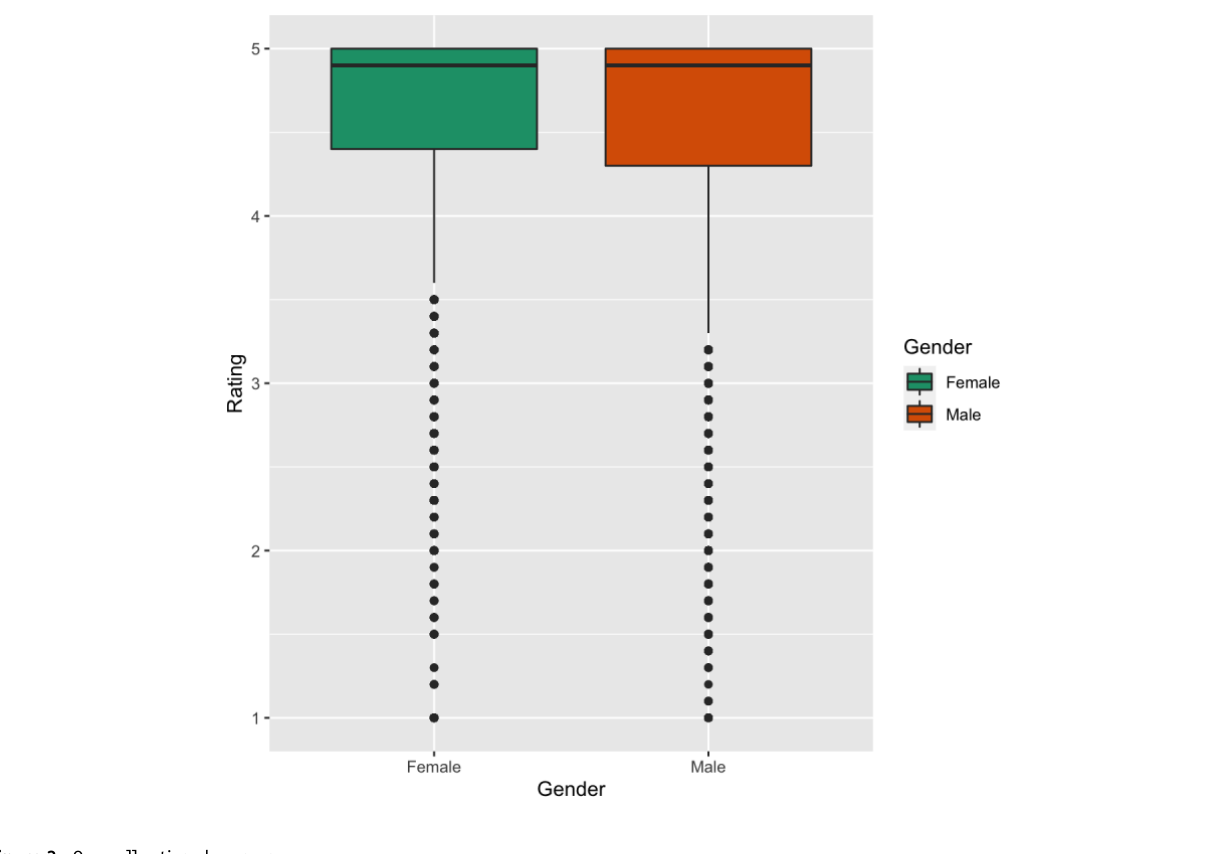
Figure 2. Overall ratings by gender.